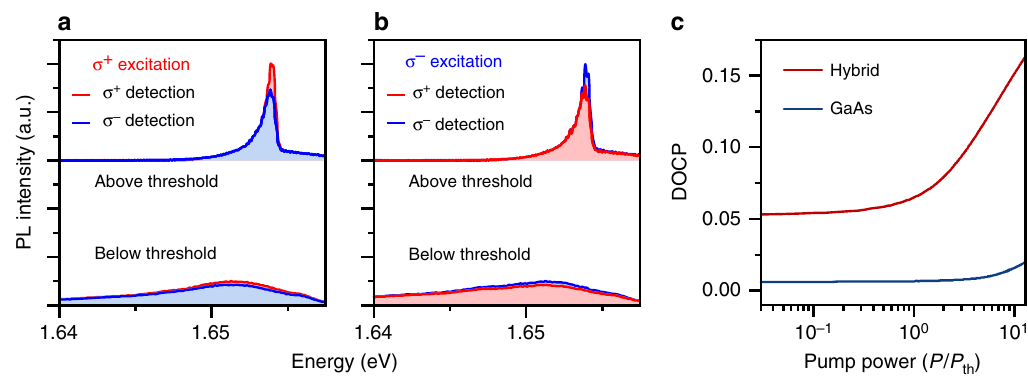
Fig. 4 Polarized emission from the hybrid condensate. a , b Polarization resolved spectra at k = 0 at a pump power of 10* P th above and below the laser threshold for σ + ( a ) and σ − ( b ) excitation. The retained DOCP is 17.9% and 16.4%, respectively. In contrast, below the threshold only 9.8% ( σ + ) and 7.2% ( σ − ) are conserved. c Calculation of the pump power evolution of the degree of circular polarization of hybrid polaritons (red) and GaAs exciton